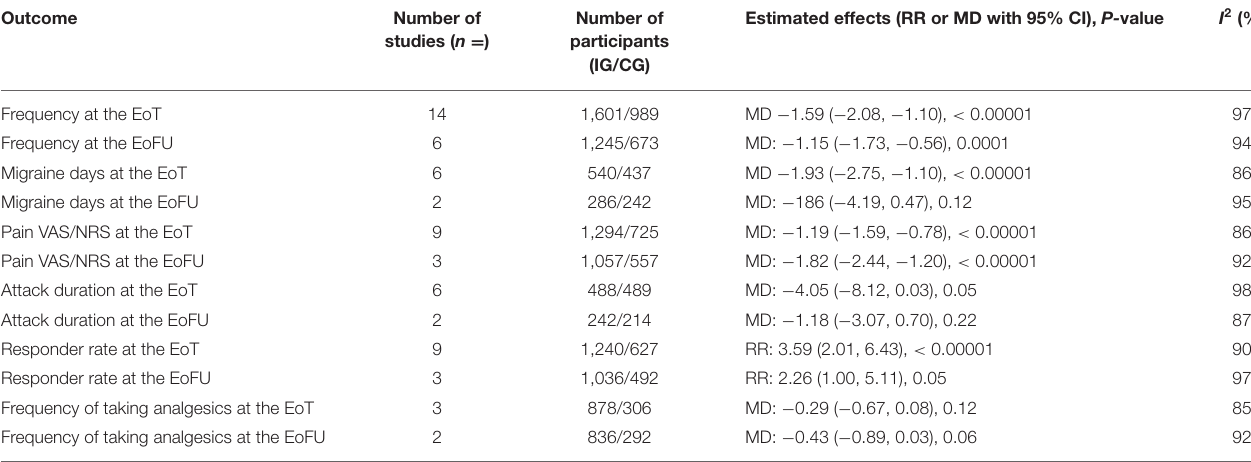
TABLE 3 | Treatment effects of all outcome measures.